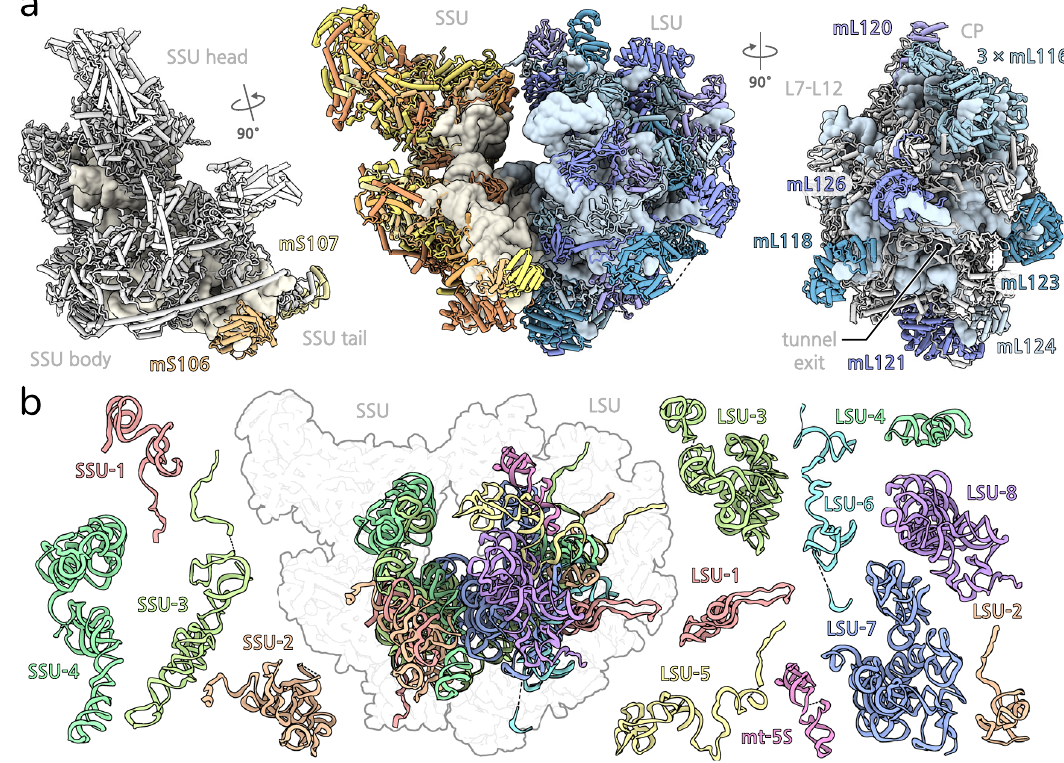
Fig.1|Overallstructureofthe P.magna mitoribosomewithfragmentedrRNA. a View of the monosome with proteins coloured by subunit, and individual SSU (left) and LSU (right) with their corresponding HEAT proteins highlighted.